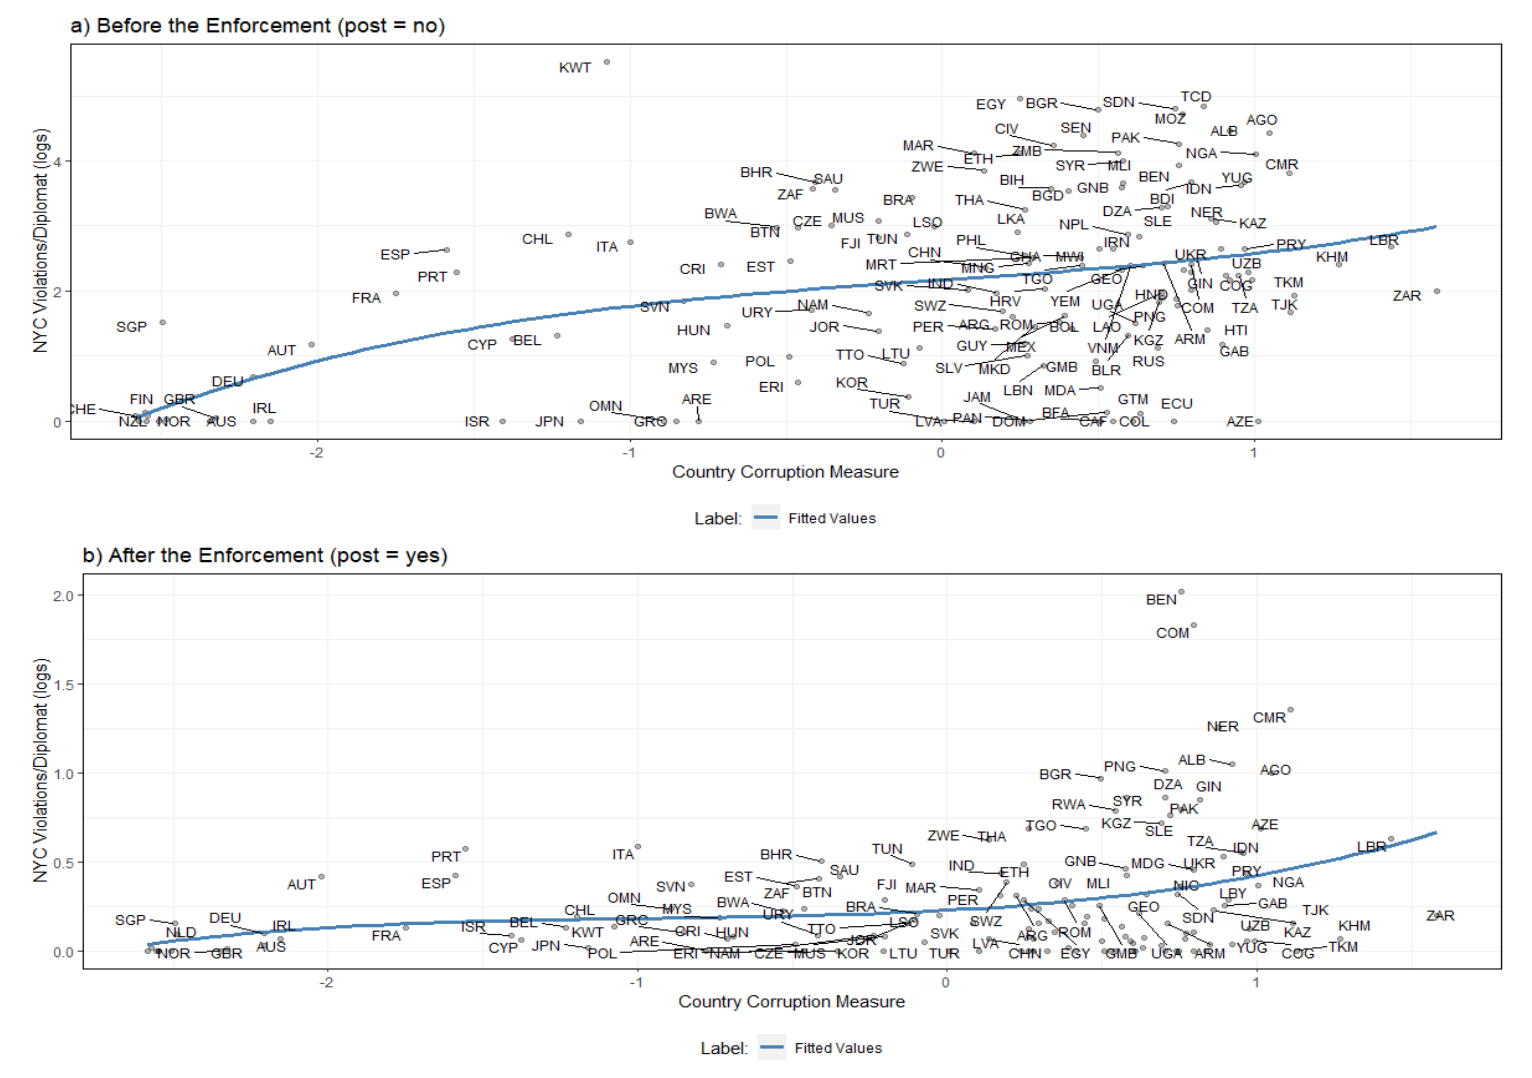
Figure 1. Parking violations and country corruption index from Fisman and Miguel [11]